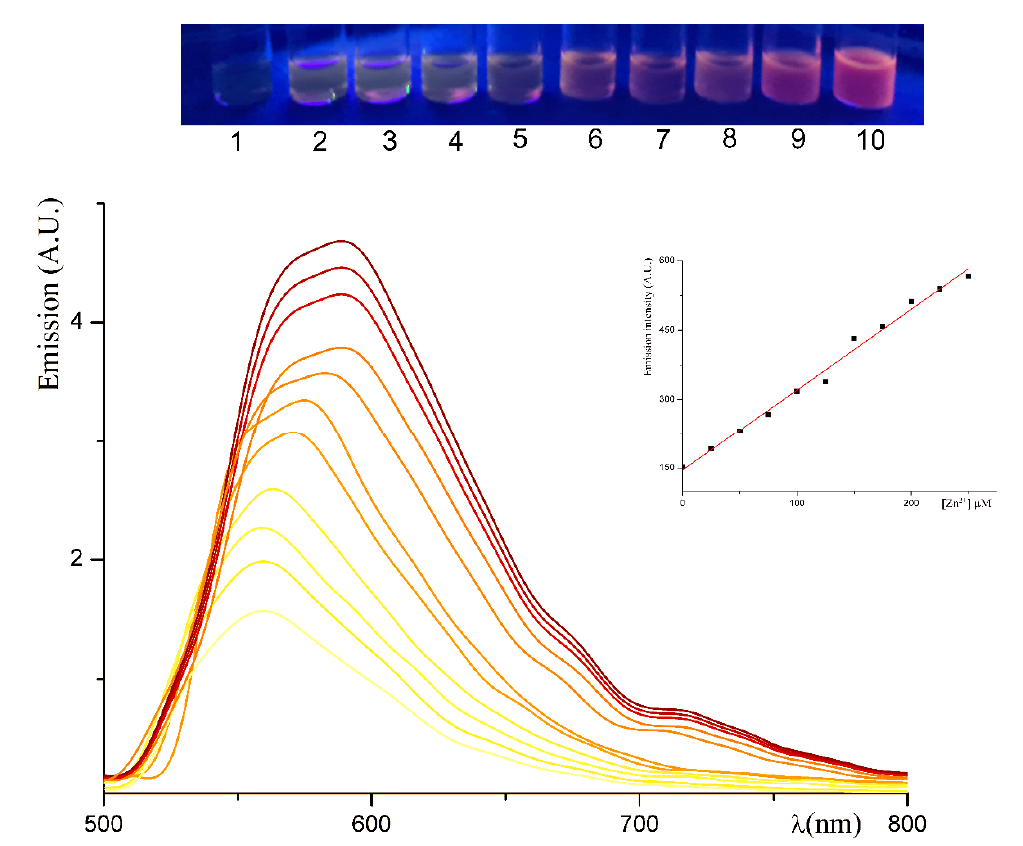
Figure 3. Fluorescence titration obtained by recording the emission spectra of 500 μ M ethanolic solution of L and upon incremental addition of ZnCl 2 (0.100 M in ethanol), excited at 450 nm. Inset above: naked eye-perceivable emission under a UV–VIS lamp operating at 365 nm of the samples obtained by growing increments of the Zn:L ratio. Specifically, the vial marked zero is the solution of the unbonded ligand; in the vials, 1–10 Zn:L ratio grew from 0.05:1 to 0.5:1. Inset below: the graphic of the relationship between emission intensity and concentration of Zn 2+ .